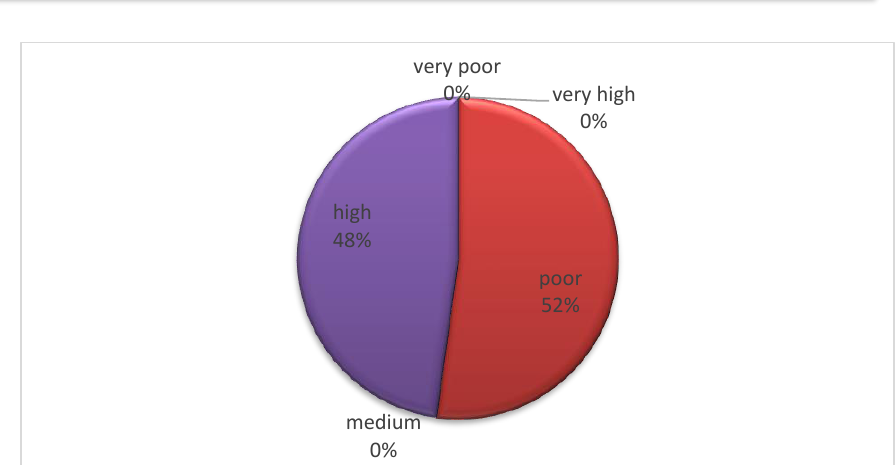
Figure 6. Ibnu Rusdy Students’ HOTS based on Logic and Reasoning Indicator in Percenta ge